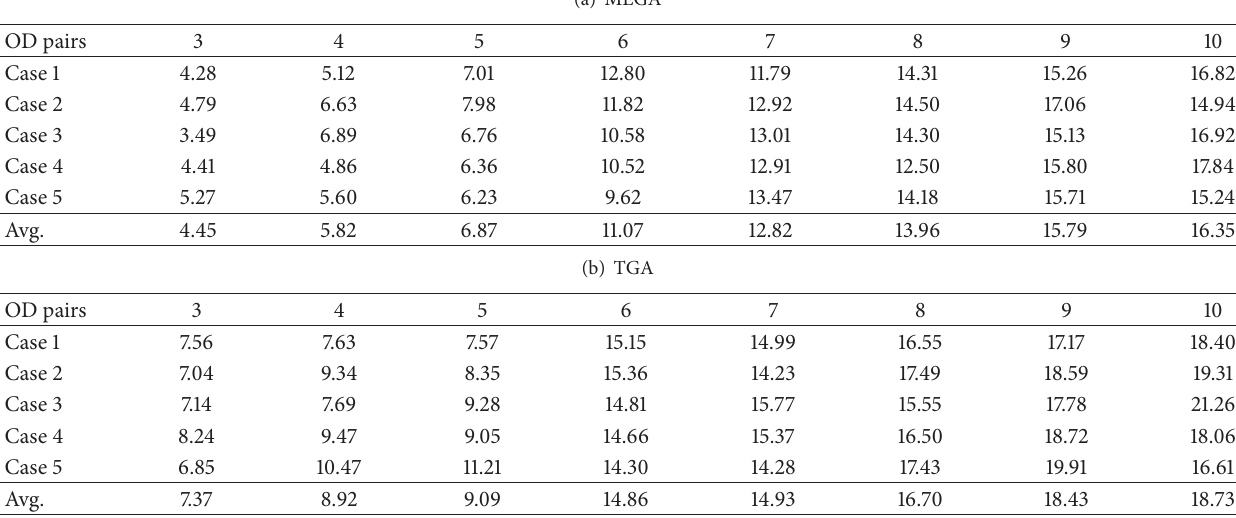
Table 8: The standard deviation of results for the low-rate cases (0.25Mbps) obtained by (a) MEGA and (b)